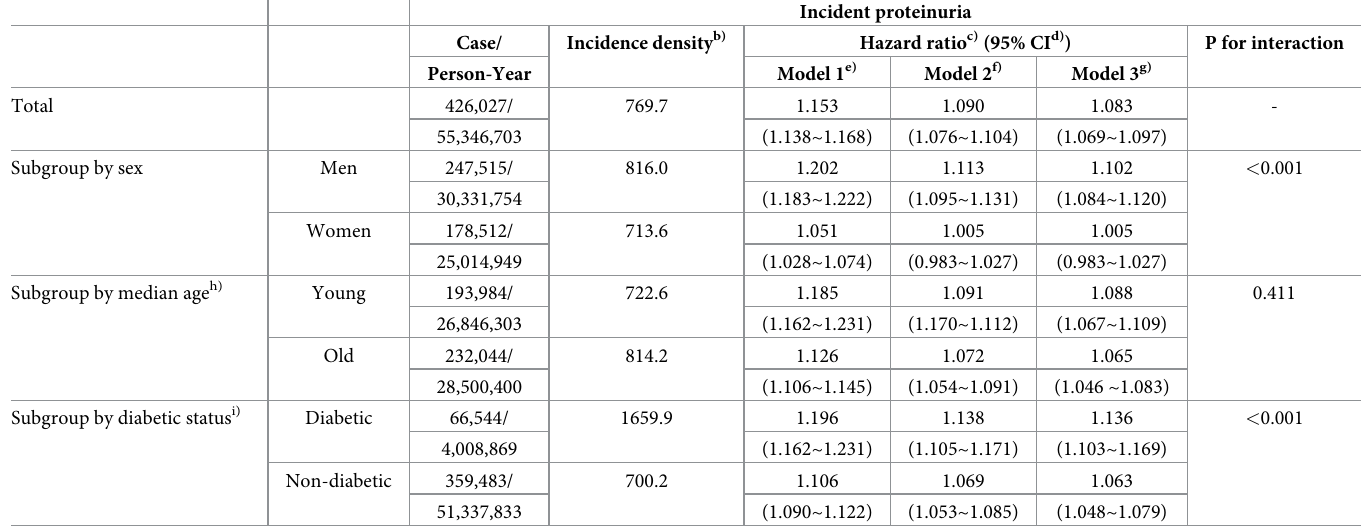
Table 2. The association of renal hyperfiltration (RHF) a with higher hazard ratios for incident